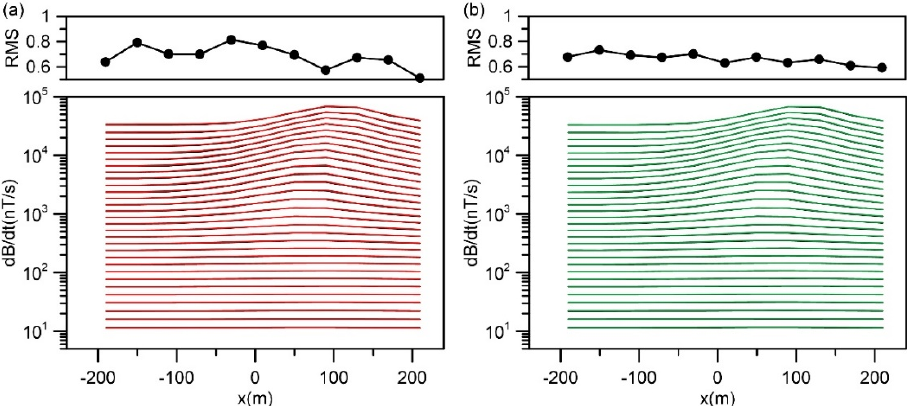
Figure 9. Data fitting and RMS for profile in Figure 3b for the synthetic example 2. ( a ) Anisotropic inversion; ( b ) isotropic inversion. The black lines are for the inversion data, while the red and green lines are for predicted data.